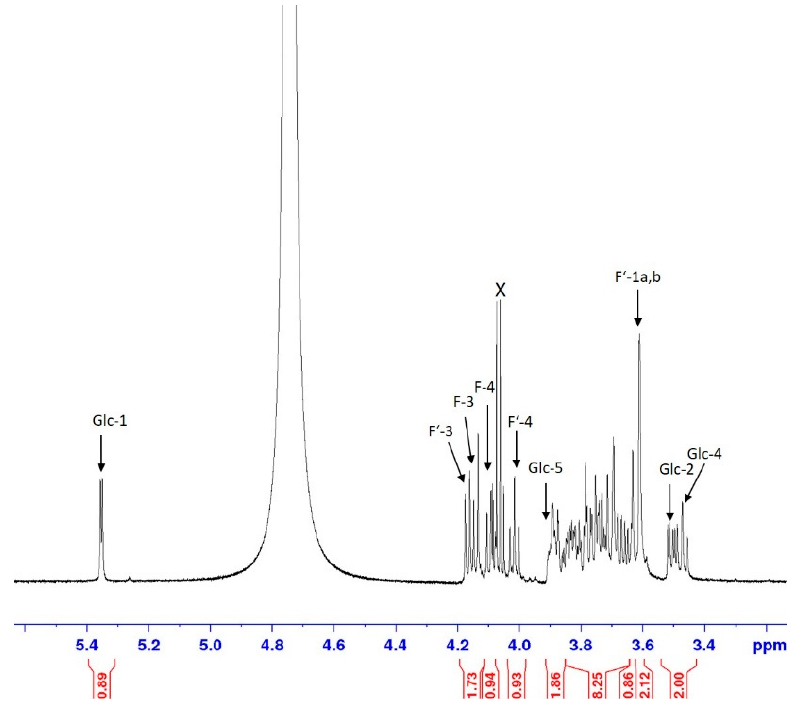
Figure 10. Expansion plot of the 600 MHz 1 H NMR spectrum. X denotes a contaminant.